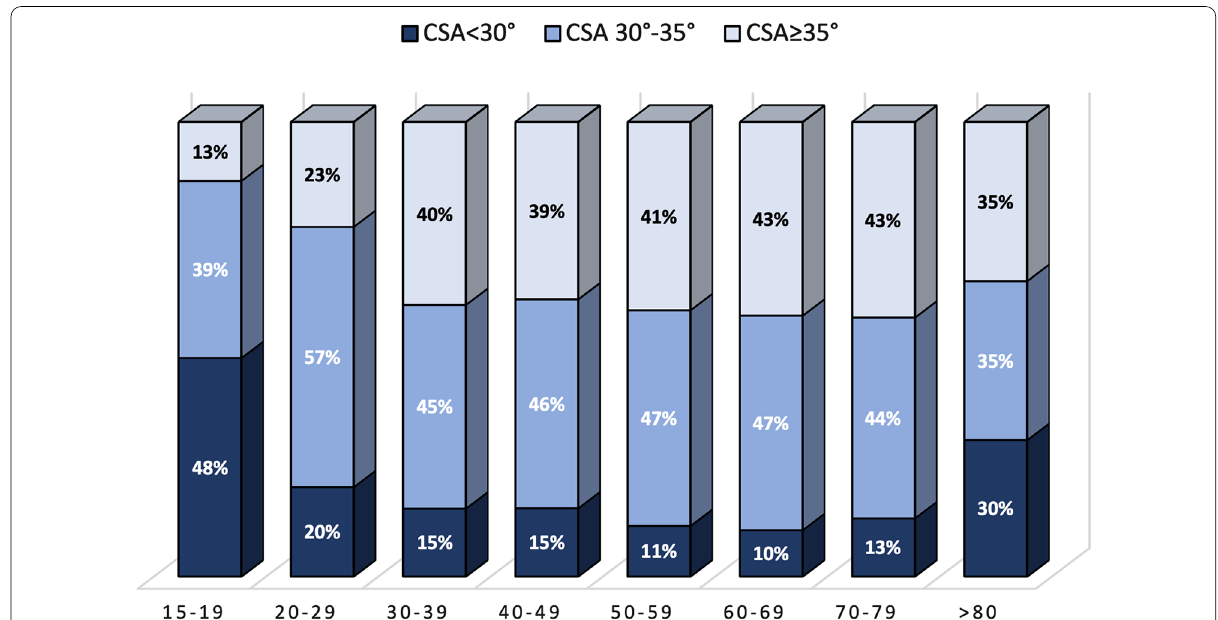
Fig. 3 Distribution of CSA in the different age groups according to the three subcategories of CSA values (< 30°; 30–35°;